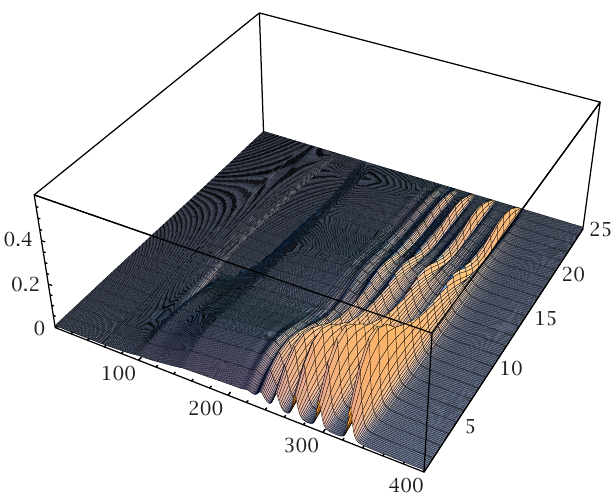
Figure 5.3 . Three-dimensional (x,y,z) plot of the wave profile ψ(z,x,t) at t = 0 . 02second for the upper half of the tank. The hor- izontal numbers ( 25 , 400 ) indicate the number of mesh points used in plotting in x and z directions while the dimensions are 12.5cm in z and 50cm in x ,